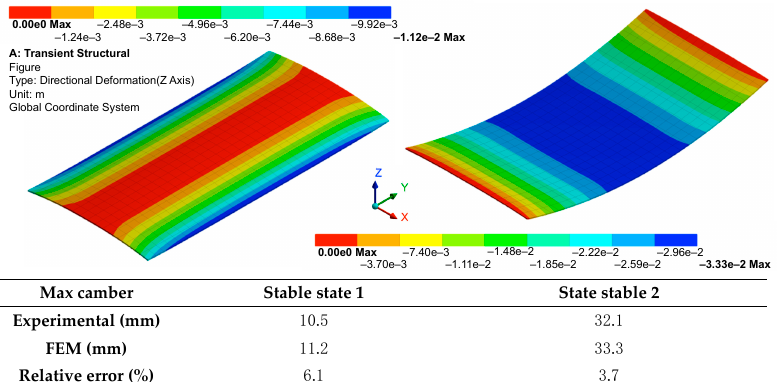
Figure 13. FE bistable model (two stable state shapes deformations): simulated and measured cambers .